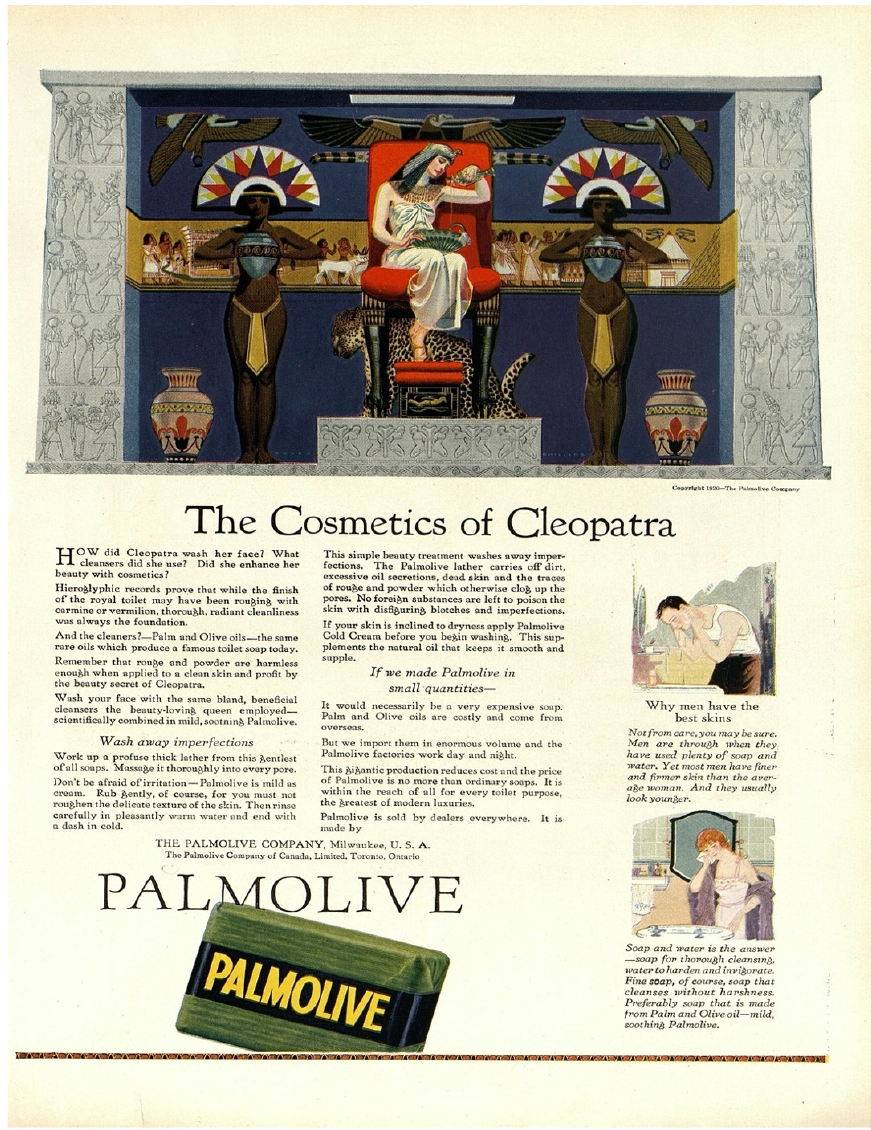
Figure 6. Palmolive Advertisement, Harper’s Bazaar , November 1920, vol. 55, no. 11, p. 112a. (Image published with permission of ProQuest LLC. Further reproduction is prohibited without permission. Image produced by ProQuest LLC as part of Harper’s Bazaar Archive. proquest.com). The accompanying image, a horizontal scene in Cleopatra’s palace laid out above the text, contains erotic undertones. Centrally positioned and elevated on a red cushioned throne, Cleopatra radiates normative beauty with her alabaster skin, subtle rouge, and red lips. Demurely sitting with her ankles crossed, she provocatively pours a mysterious translucent liquid. Skillfully holding the phallic jar, the liquid pours into a round bowl nestled gently between her knees as she softly caresses the rim of the bowl with her fin- gers. Behind her an alert leopard, a historical allusion to eroticism in the Western tradition, stands in profile with an erect tail.